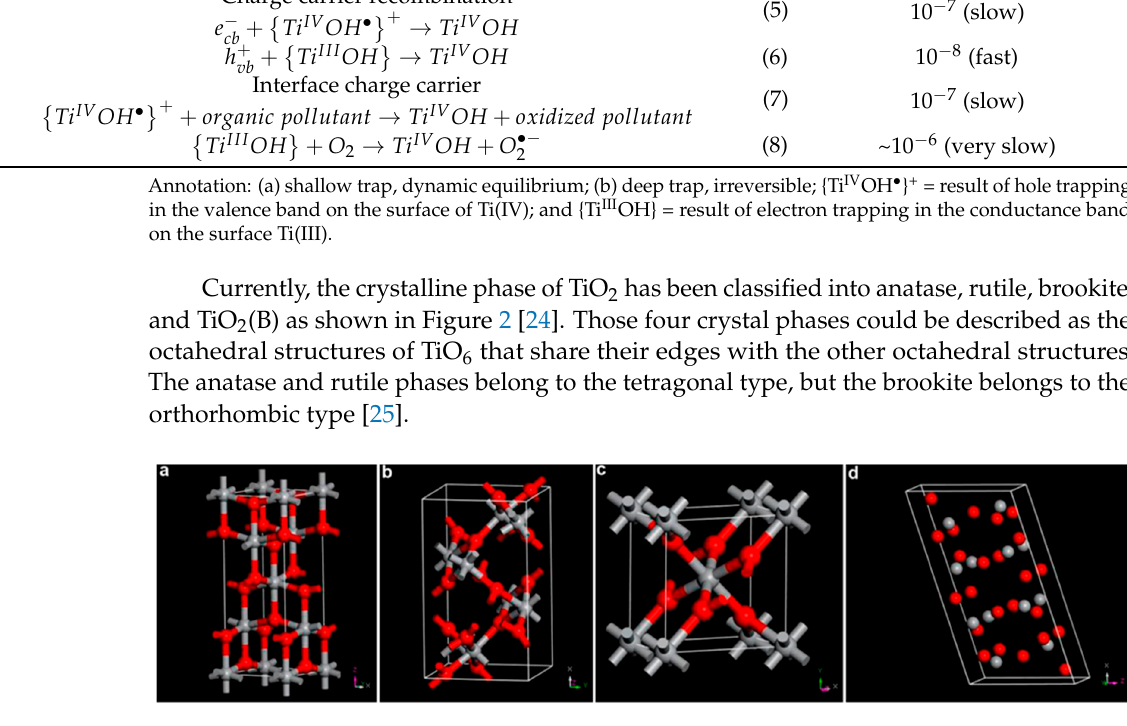
Figure 2. Representative crystal structure form of TiO 2 : ( a ) rutile, ( b ) brookite, ( c ) anatase, and ( d ) TiO 2 (B). Grey and red spheres represent the Ti 4+ and O 2- ions, respectively [24].